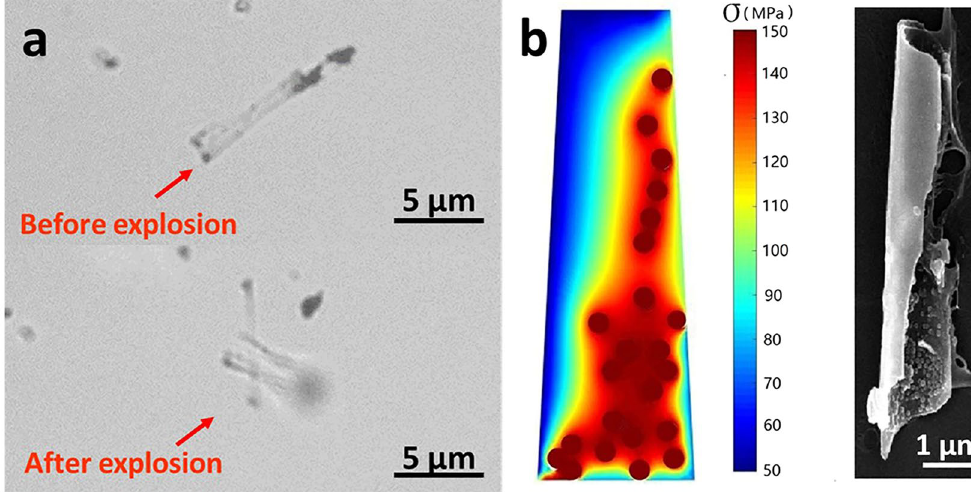
Figure 7. Gold Nanoparticles Longitudinal-Functionalized Silica Torpedo Exploded under NIR Laser Irradiation. ( a ) The time-lapsed image captured from Supplementary Video 6. ( b ) The thermal simulation and SEM image after